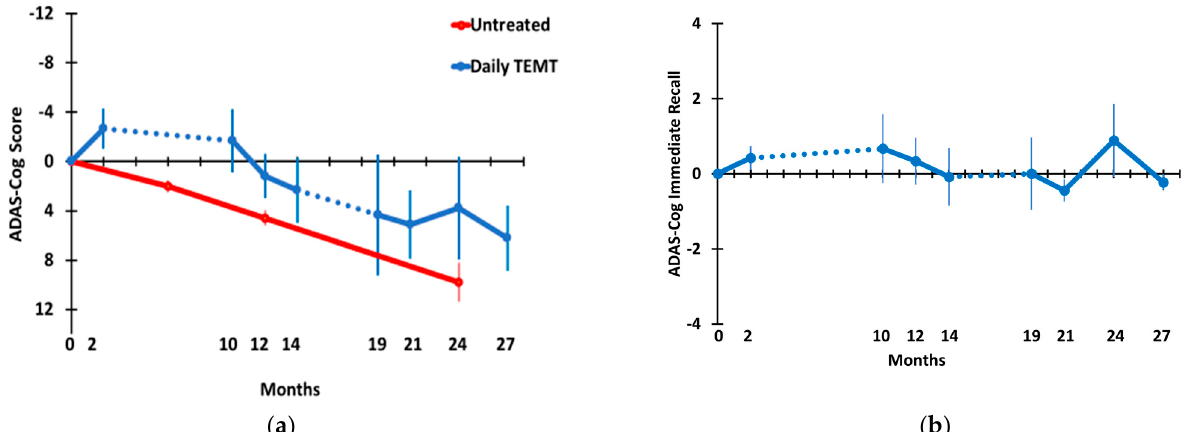
Figure 3. ( a ) ADAS-cog overall and ( b ) ADAS-cog immediate memory through 27 months. Blue data points and lines show performance of AD subjects given TEMT. Dotted lines indicate the 8M and 5M periods of no treatment. For ADAS-cog overall, the red data points and SEMs are from another clinical study evaluating ADAS-cog longitudinally in untreated AD subjects.